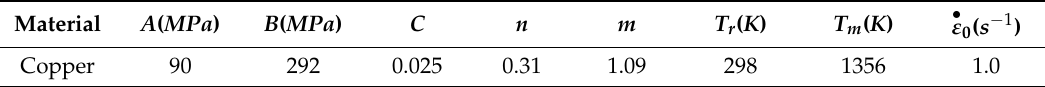
Table 2. Constitutive model parameters of copper